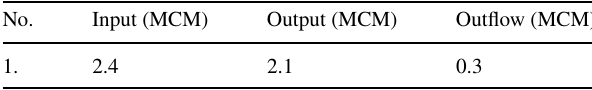
Table 3 Groundwater balance under steady state conditions